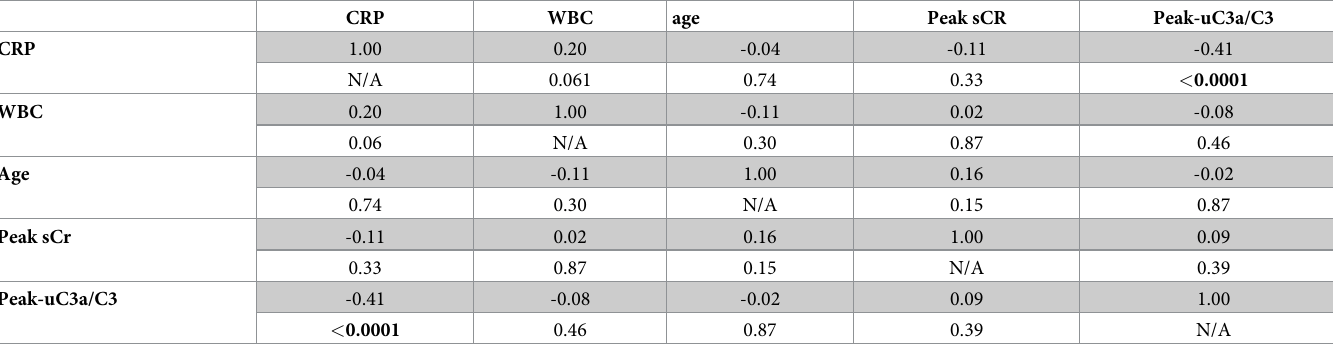
Table 3. Correlation of peak urinary C3a/C3 with age, CRP, WBC, peak sCr.